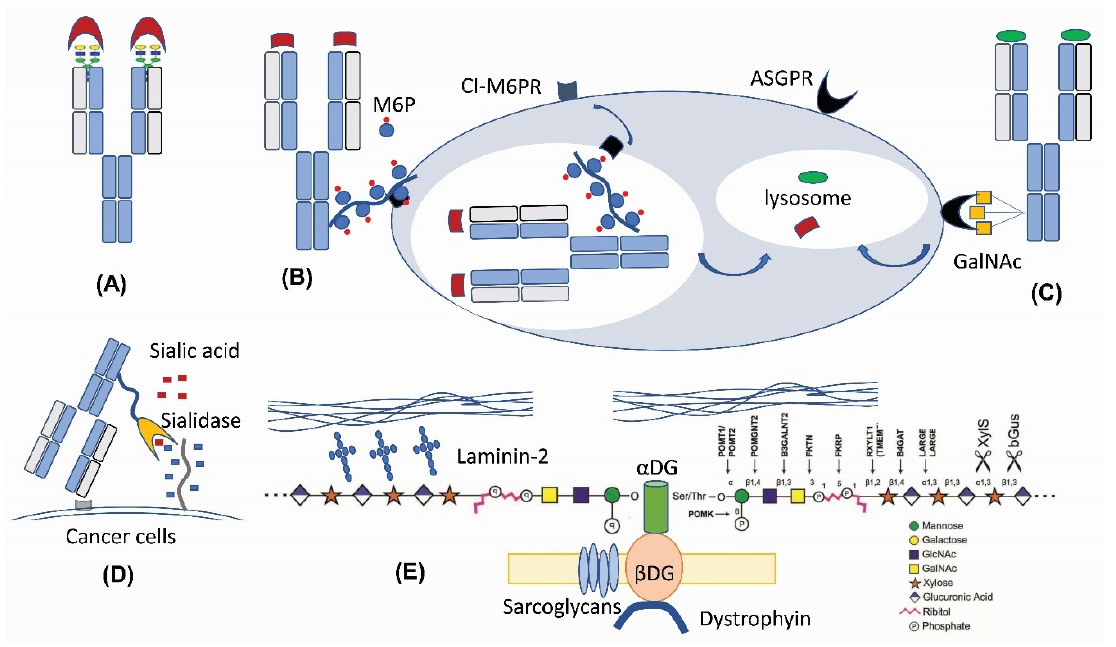
Figure 2. New therapeutic applications of N-linked and O-linked glycan modifications. ( A ) Fab N-glycan for the antibody diversity [17]. ( B ) M6P-mediated lysosomal degradation [18]. ( C ) GalNAc- mediated lysosomal degradation [19–21]. ( D ) Antibody–sialidase fusions or conjugates [22,23]. ( E ) O-mannosylation matriglycan as a functional decoration for α -Dystroglycan [24,25].